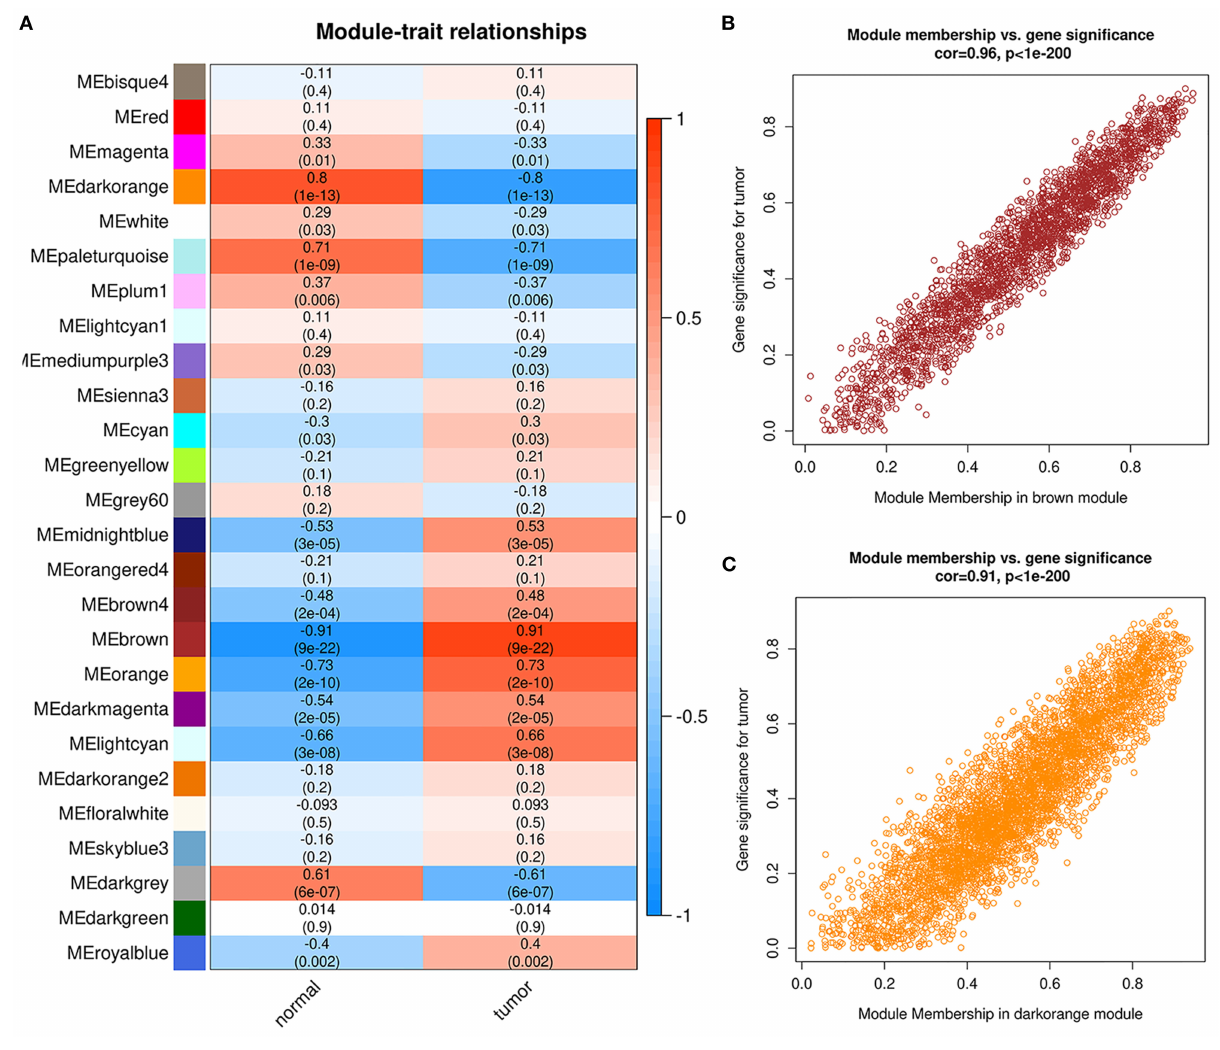
FIGURE 3 | Identification of esophageal squamous cell carcinoma (ESCC)-specific modules of GSE161533. (A) Heatmap of module–trait relationships. (B,C) Scatter plots of module membership vs. gene significance in the brown (B) and dark orange (C)